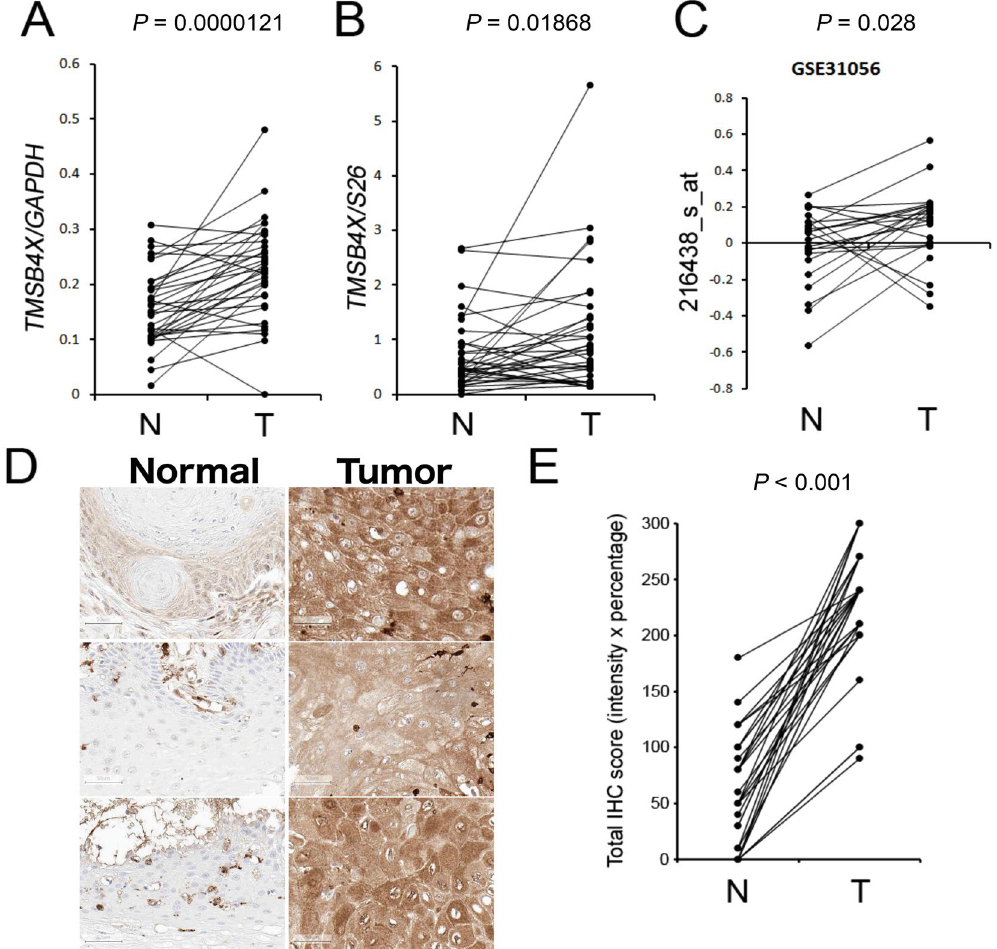
Figure 3. TMSB4X has higher RNA or protein expression level in tumor samples than in normal adjacent tissues, which was demonstrated in 3 independent HNSCC cohorts. ( A , B ) Showed the expression changes of TMSB4X in 35 NT-paired samples of KVGH cohort by RT-PCR and real-time PCR, respectively. ( C ) TMSB4X (216438_s_at) expression in 23 NT-paired HNSCC cohort in microarray dataset, GSE31056. ( D ) IHC staining in tissue microarray from 31 NT-paired HNSCC samples of TMUH cohort, representative 3 NT-paired images. ( E ) TMSB4X IHC expression was scored by multiplying intensity and percentage. The P value was calculated by paired